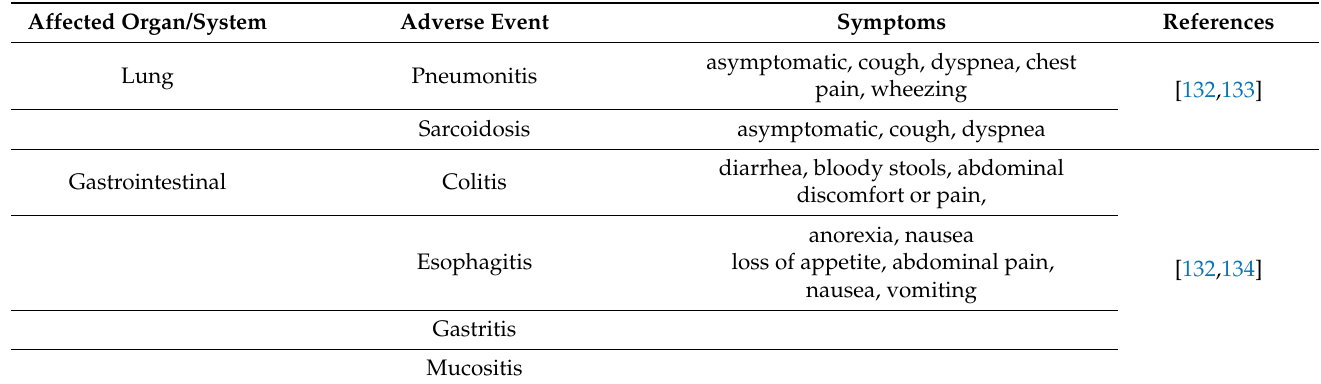
Table 2. Adverse events after PD-1, PD-L1